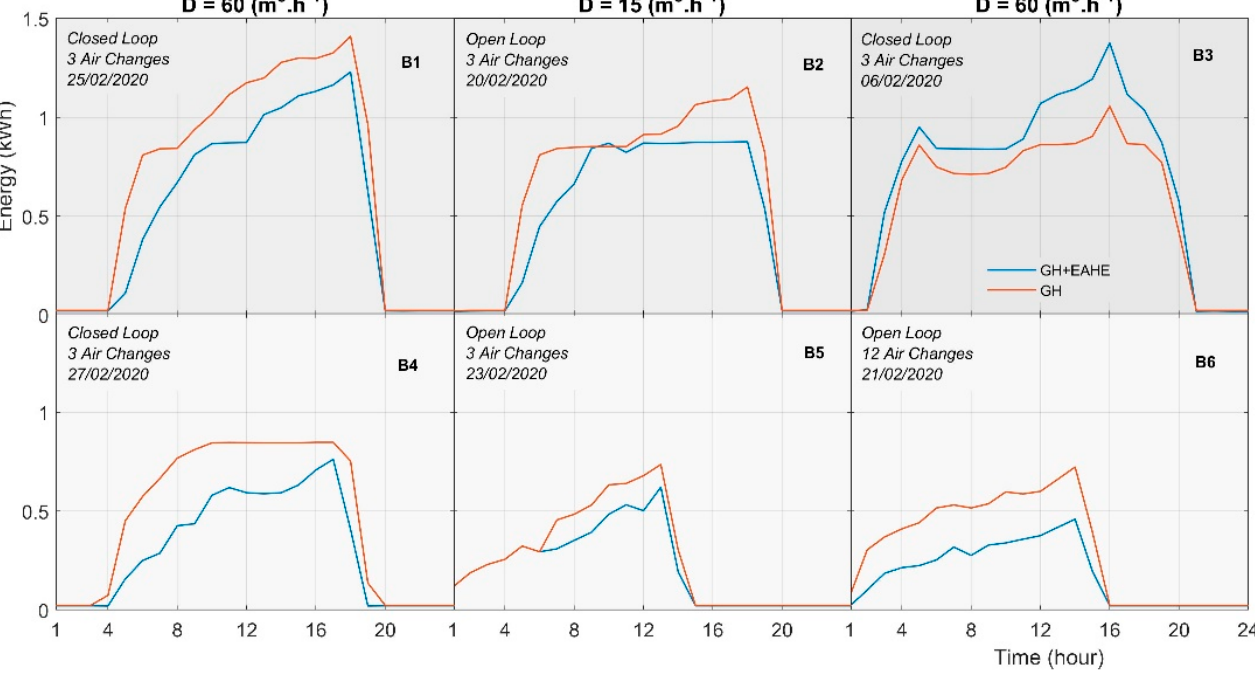
Figure 7. Energy consumption.